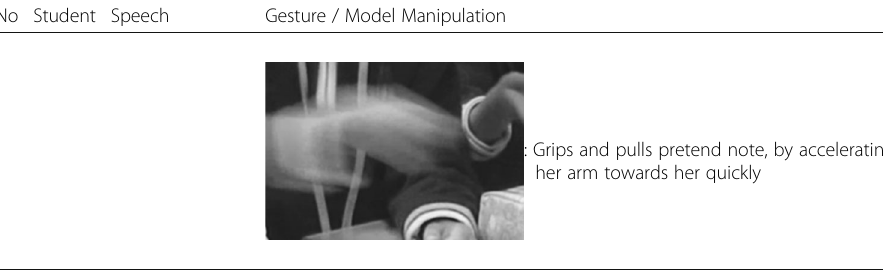
Table 1 Identification of Science Concepts in Group 2 (Continued) No Student Speech Gesture / Model